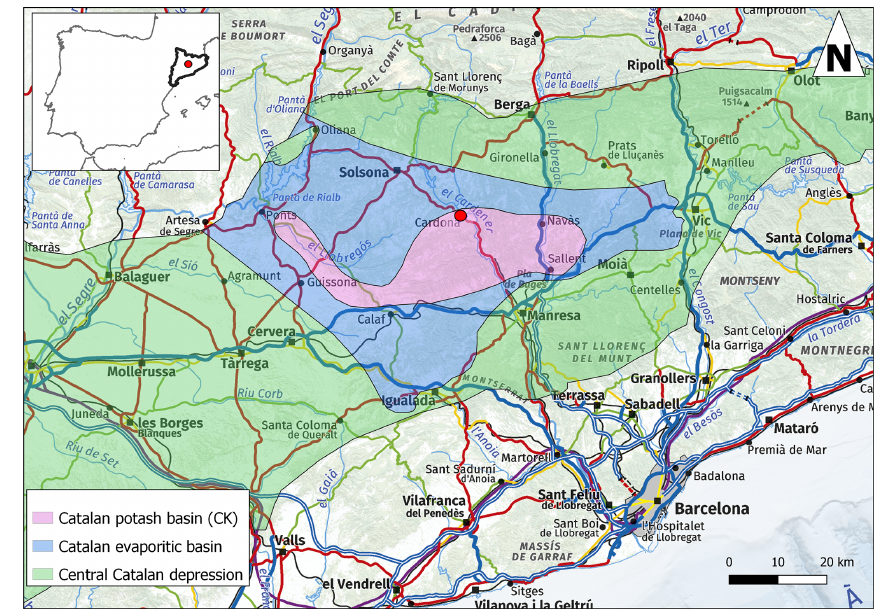
Figure 1. Location Map of Cardona town on the Catalan Potash basin (CK) with is part of the evaporitic basin of the Central Catalan depression located at NE Spain.